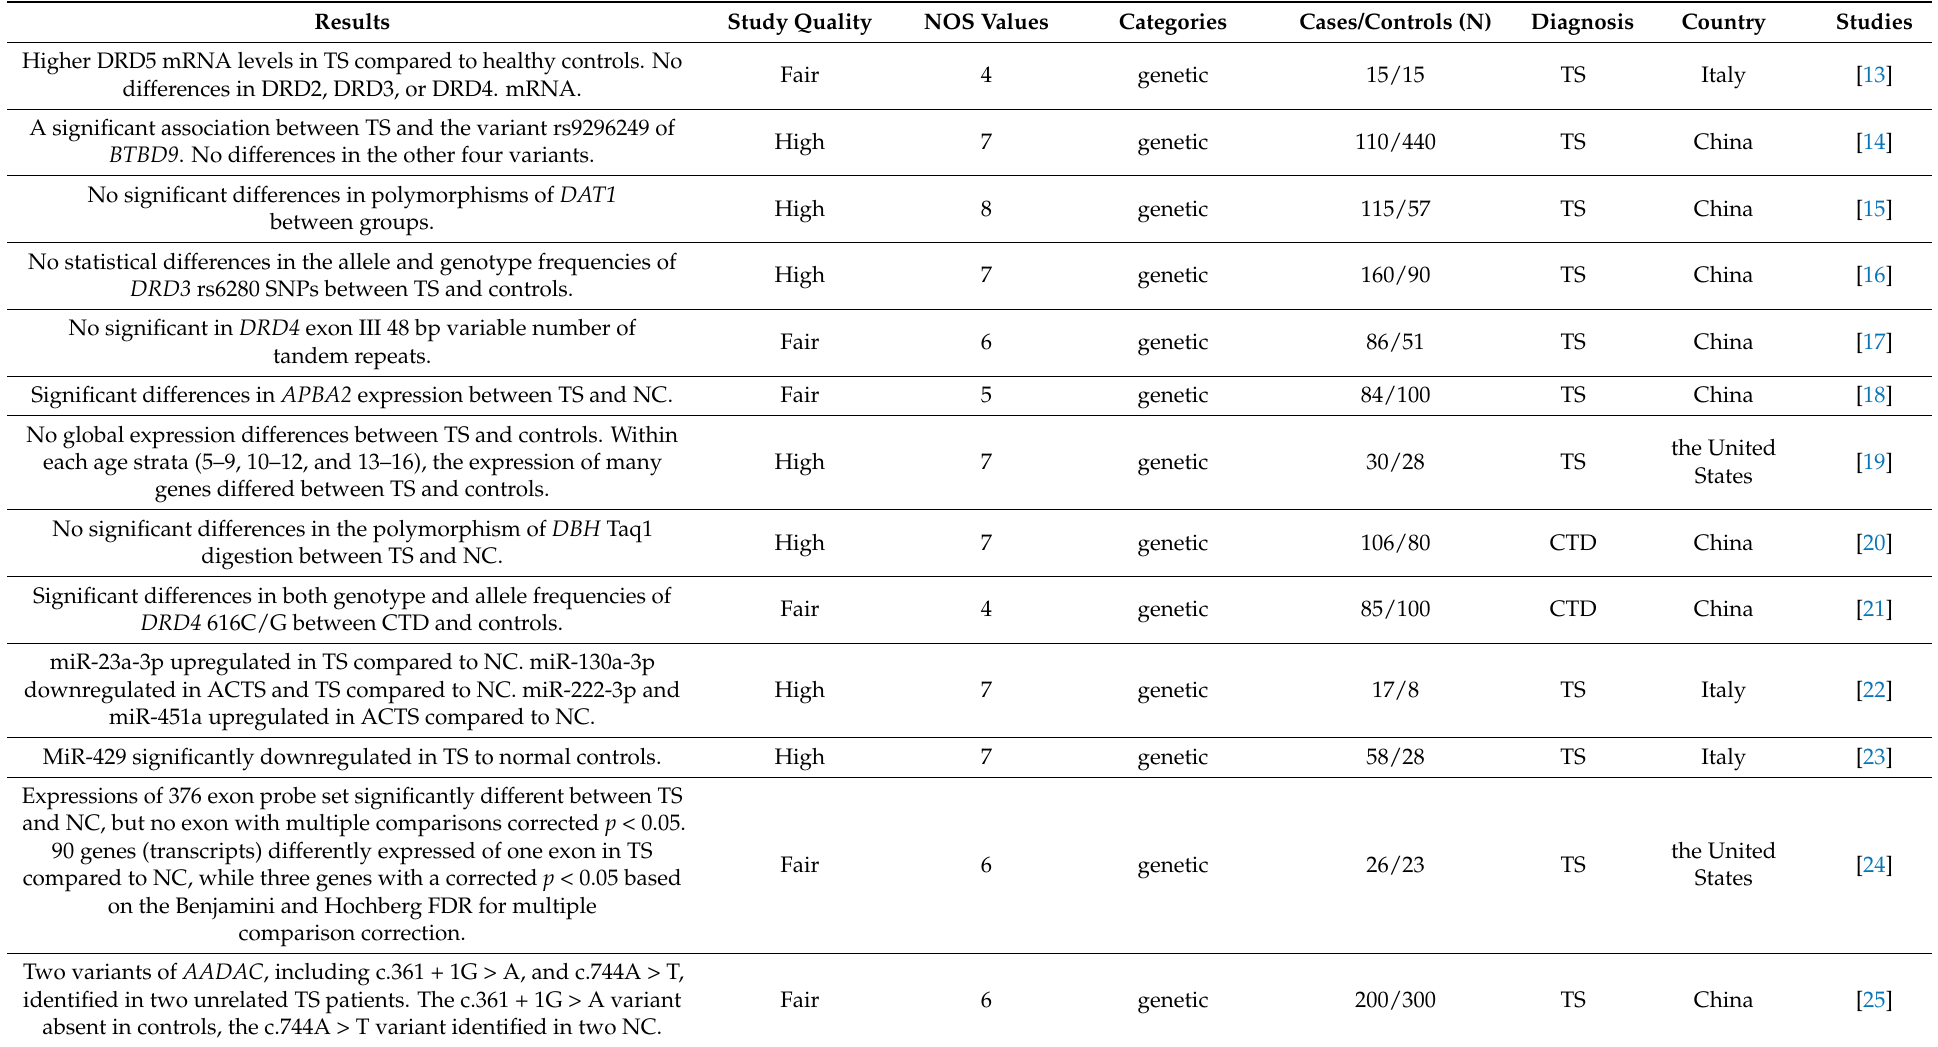
Table 1. Characteristics of the included